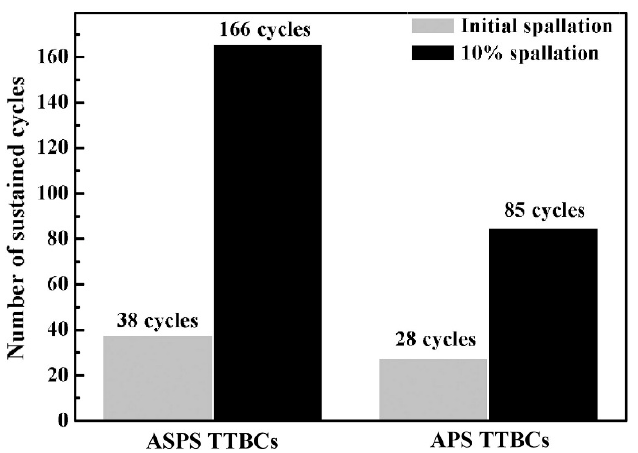
Figure 34. Number of sustained cycles at 1100 ℃ for SPS coating and APS coating [181] .